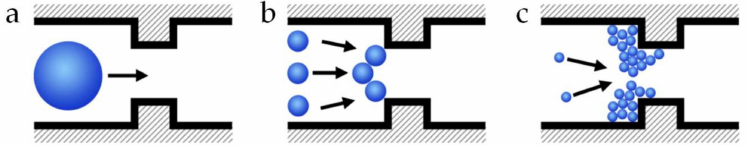
Figure 4. Pore blocking mechanisms: ( a ) sieving, ( b ) bridging, and ( c ) aggregation [43]. Image used with permission from the